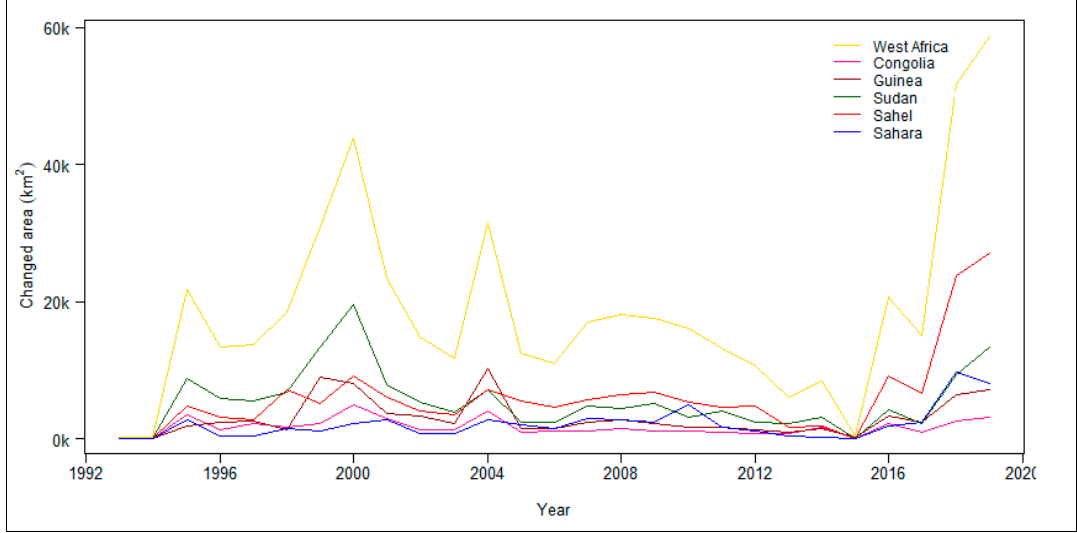
Figure 6. Annual variation of land cover change area for the five bioclimatic zones of West Africa.